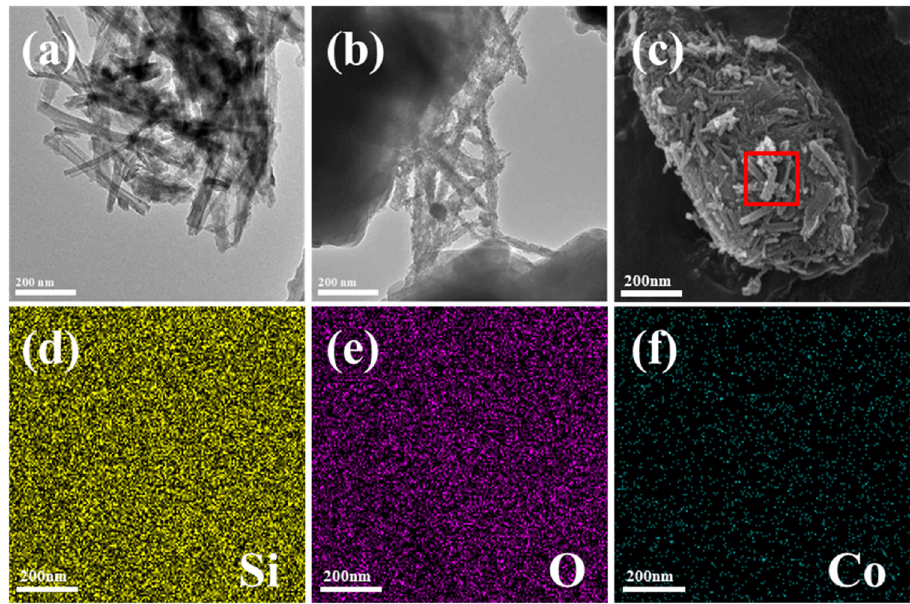
Figure 3. ( a ) TEM image of ATP; ( b ) TEM image of ZIF-67@ATP; ( c ) SEM image of ZIF-67@ATP; EDS mapping distribution of ( d ) Si; ( e ) O; and ( f ) Co.